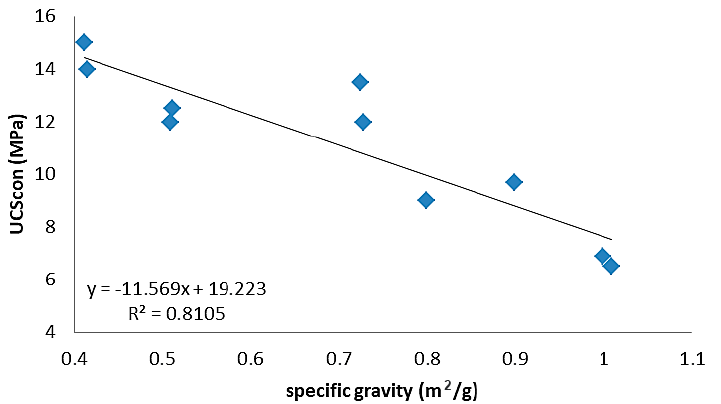
Figure 9. Specific gravity of the tested aggregates vs. the uniaxial compressive strength test of the produced concrete specimens.